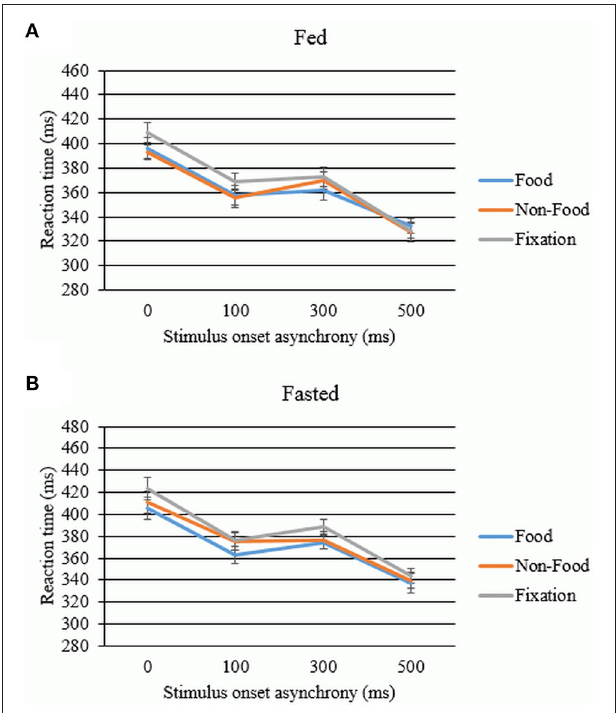
FIGURE 2 | Benefit of the warning cue in the (A) fed and (B) fasted states. Error bars denote standard error (ms).